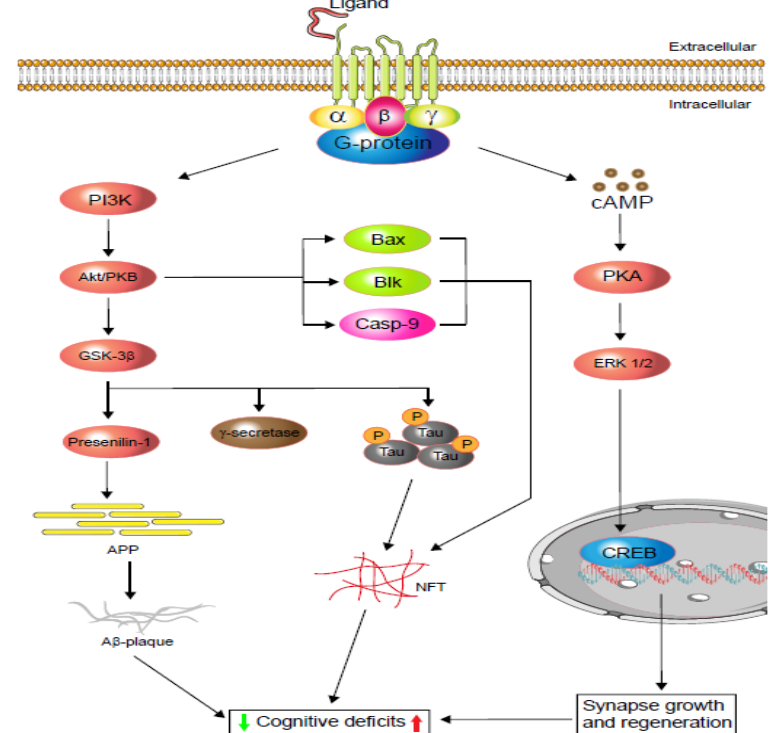
Figure 1. Schematic display of G-protein-coupled receptors (GPCRs) signalling in cognitive impairment. Depending on the agonist or inverse agonist ligand binding, the PI3 / Akt-signalling pathway signals Bax and Casp-9 while increasing neurofibrillary tangle (NFT) formation via phosphorylation. PI3 / Akt-signalling hyperphosphorylation also activates glycogen synthase kinase-3 β (GSK-3 β ), which increases either or both tau protein phosphorylation and amyloid precursor protein (APP). Phosphorylated tau protein forms neurofibrillary tangles (NFTs) and regulates